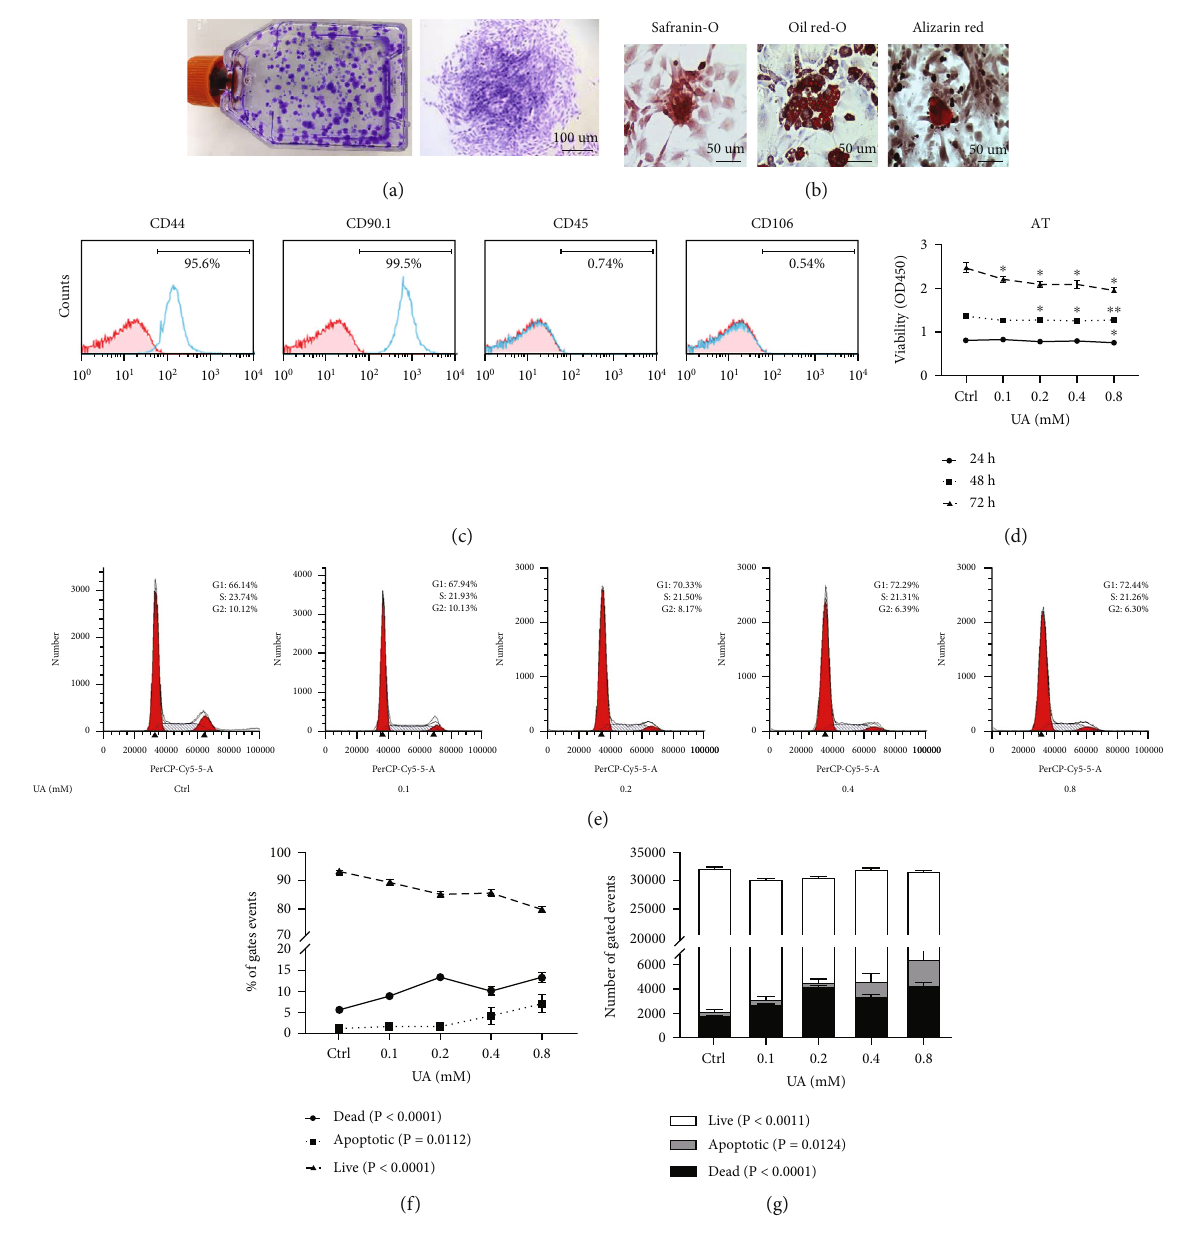
Figure 2: E ff ects of UA treatment on TSPC viability and survival. Characteristics of primary cells extracted from SD rat tendon were determined in (a) – (c). (a) Primary cell colonies stained with crystal violet at 12 days. (b) Primary cells cultured under di ff erentiation conditions for 21 days, followed by safranin O, oil red O, and alizarin red S staining to detect chondrogenic, adipogenic, and osteogenic di ff erentiation, respectively. (c) Flow cytometry analysis of the expression of cell surface markers related to stem cells (CD44 and CD90.1), leukocyte (CD45), and endothelial cell (CD106). (d) CCK8 assays were used to assess TSPC proliferation over a course of 72h, with the addition of PBS or UA (0.1, 0.2, 0.4, and 0.8 mM). (e) Representative images show cell cycle distribution with fl ow cytometric analysis with UA treatment after 48h. Changes in the percentile (f) and numbers (g) of live, apoptotic and dead TSPCs were assessed over 48h with UA treatment. A control treated with PBS was included in all experiments. Results are presented as the mean ± SEM from three independent experiments, using TSPC isolates from 3 individual rats. Data were analyzed using ANOVA. ∗ P < 0 : 05 ; ∗∗ P < 0 : 01 versus PBS-treated control at the relevant time